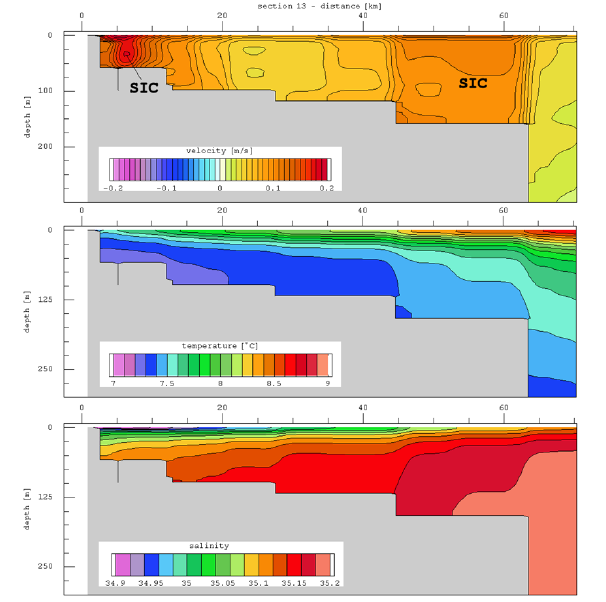
Fig. 12. Simulated 1992–2006 mean of flow (positive (red) values denote north-eastward flow), temperature and salinity across section 13. See Fig. 6 for section